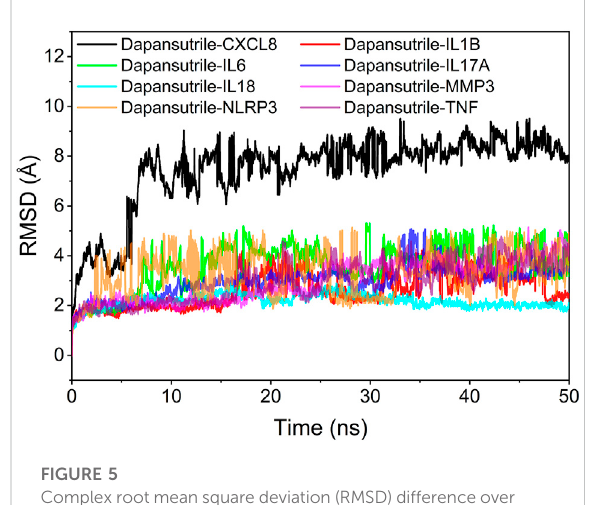
FIGURE 5 Complex root mean square deviation (RMSD) difference over time.